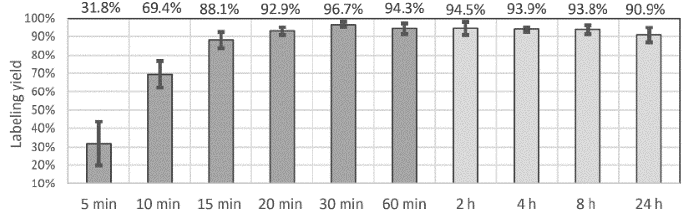
Figure 1. Radiolabeling yields of [ 89 Zr]Zr(oxinate) 4 up to extraction at 60 min, and in the subsequent stability samplings in PBS (2 to 24 h).